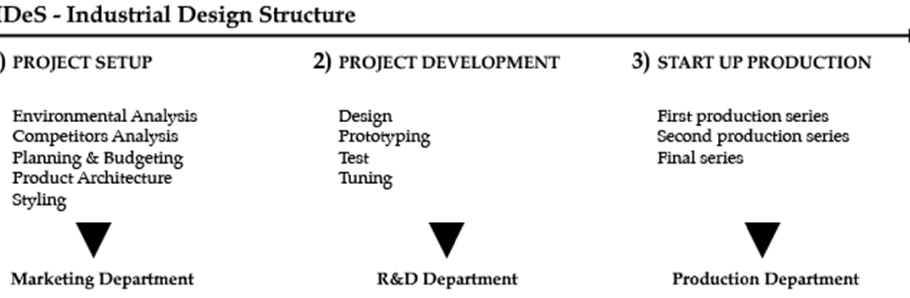
Figure 1. IDeS method outline.